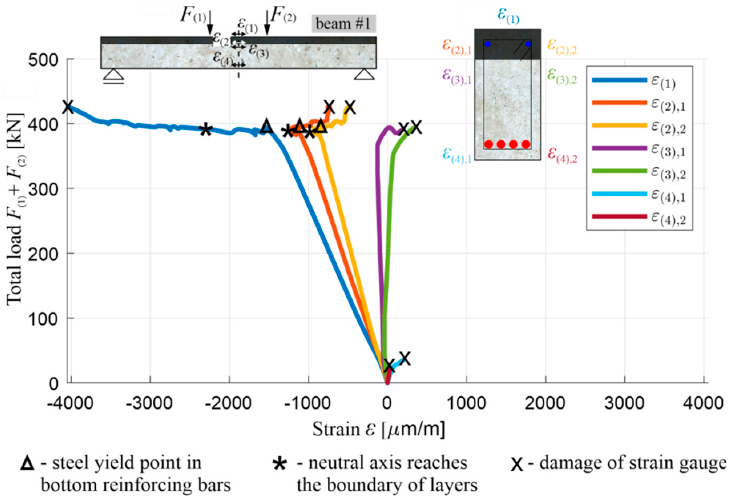
Figure 24. Diagram of the total load in the function of the measured strains at the middle of the span for beam #1. for beam